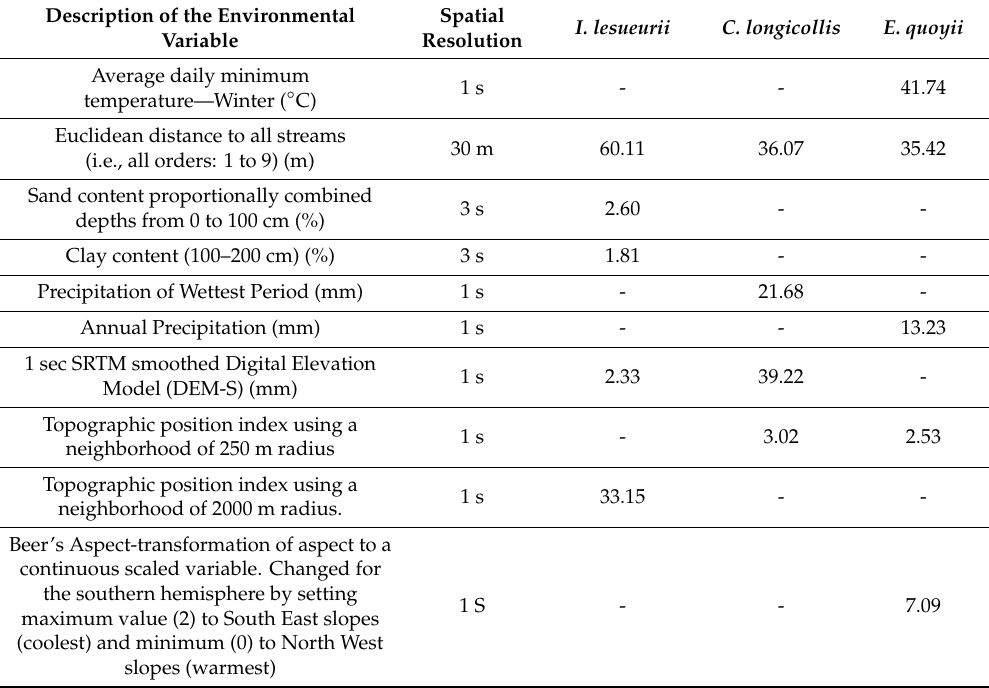
Table 3. The relative contribution of the environmental variables to the predictions for each of the three species. The Euclidean distance gives the distance from each cell in the raster to the closest stream of any order. Particle sizes for sand (0.02–2 mm) and clay (0.0002–0.002 mm) are as defined by [30]. The Topographic Position Index (TPI) compares the elevation of each cell in a digital elevation model (DEM) to the mean elevation of a distance of 250 and 2000 m around each cell [31]. The 1 s DEM-S is a national elevation data product derived from the Shuttle Radar Topography Mission (SRTM) data